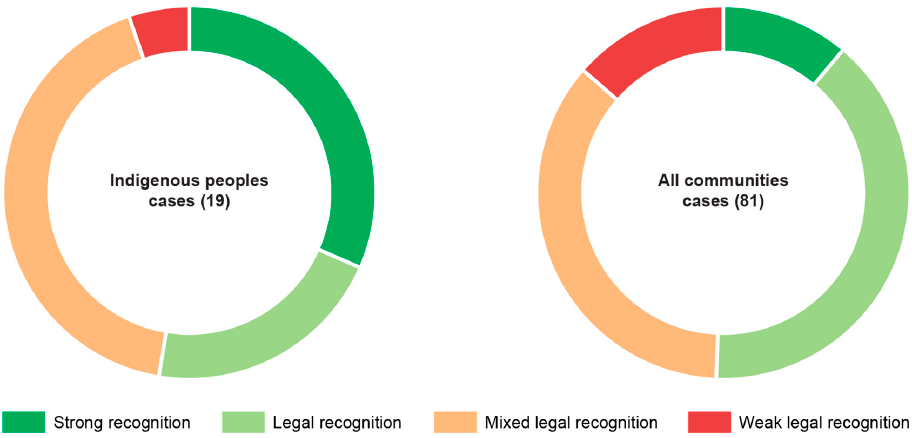
Figure 4. Recognition of indigenous peoples’ water rights versus all communities.